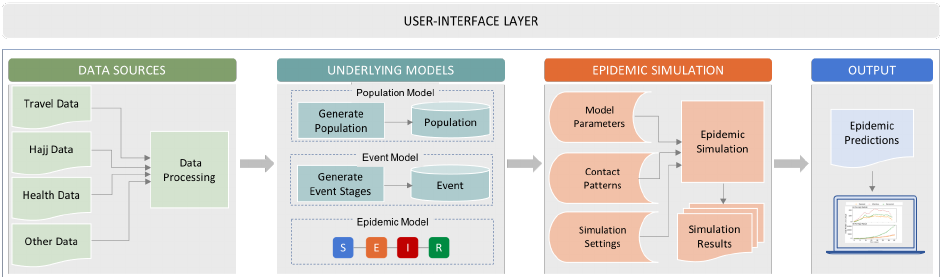
Figure 3. The proposed framework for epidemic forecasting in Hajj seasons.